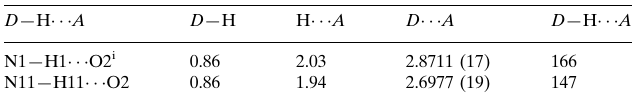
Hydrogen-bond geometry (A˚ , (cid:1)